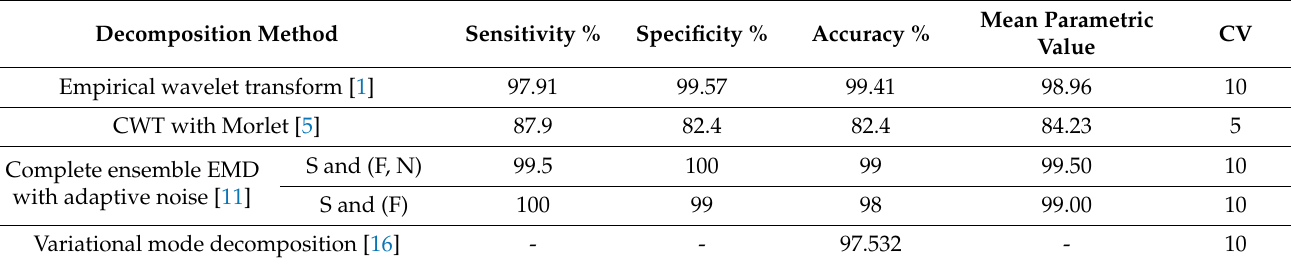
Table 4. Performance comparison of seizure detection method using random forest classifiers.